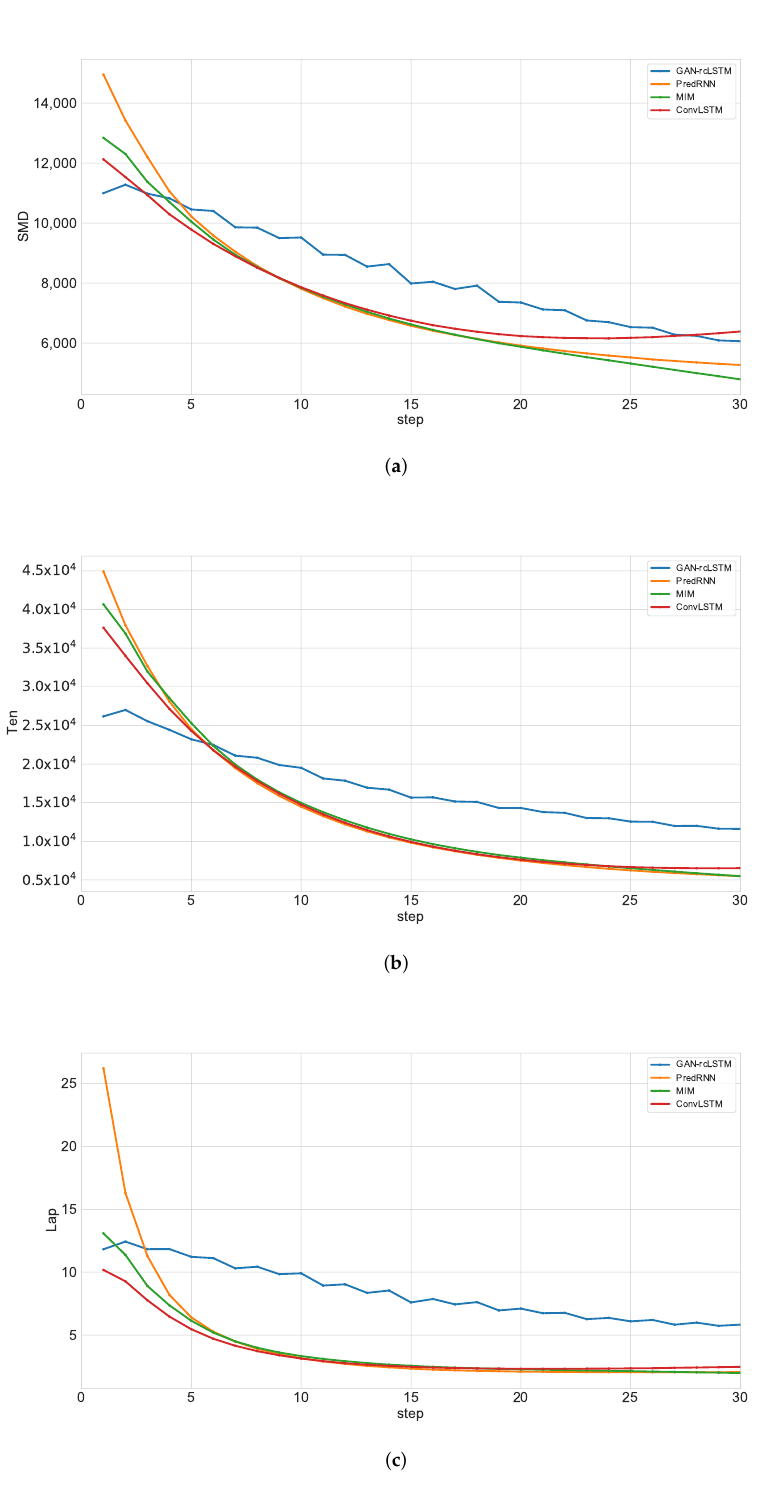
Figure 8. Comparison of predictions from different models for the next 30 frames, with a 6-min interval between each frame. ( a ) is the Sum of Modulus of gray Difference, ( b ) is the Tenengrad, and ( c ) is the Laplacian variance. A lower curve indicates a clearer extrapolation